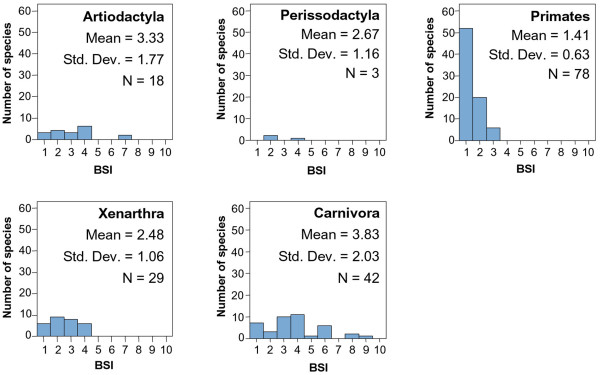
BSI histograms for macrommamalian orders.